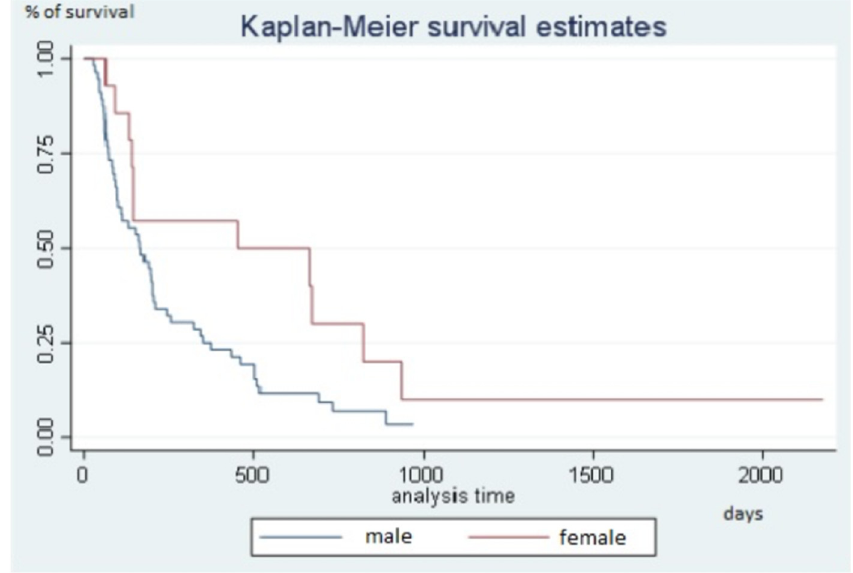
Figure 3. Progression-free survival in males and females.